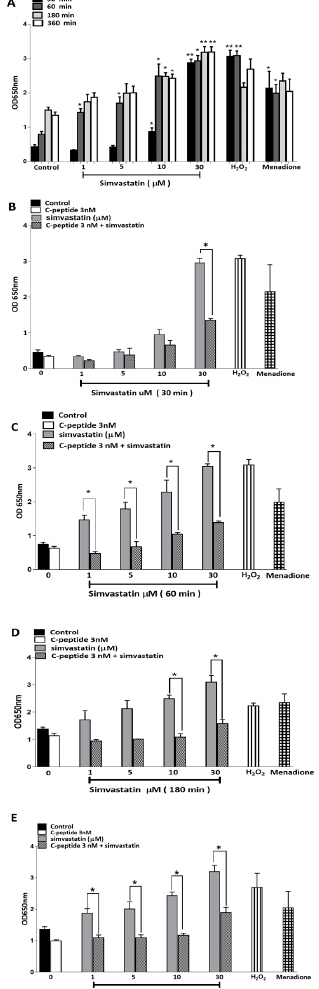
Figure 6. Simvastatin-induced ROS generation in L6 myoblasts, assessed by colorimetric detection using Nitro Blue Tetrazolium (NBT). ( A ) Cells were serum starved overnight in DMEM and then treated with a range of simvastatin concentrations for the times shown. H 2 O 2 (100 µM) and (M) menadione (30 µM) were used as positive controls. Data are pooled from three independent experiments and presented as mean ± SEM. * p < 0.05; ** p < 0.01 compared to control at the same time point. ( B – E ) C-peptide blunting of simvastatin-induced ROS generation in L6 myoblasts. Cells were serum starved overnight in DMEM and treated with simvastatin alone or in-combination with 3 nM C-peptide for 30–360 min. H 2 O 2 (100 µM) and menadione (M) (30 µM) were used as positive controls. Data are pooled from three independent experiments and presented as mean ± SEM. * p < 0.05.